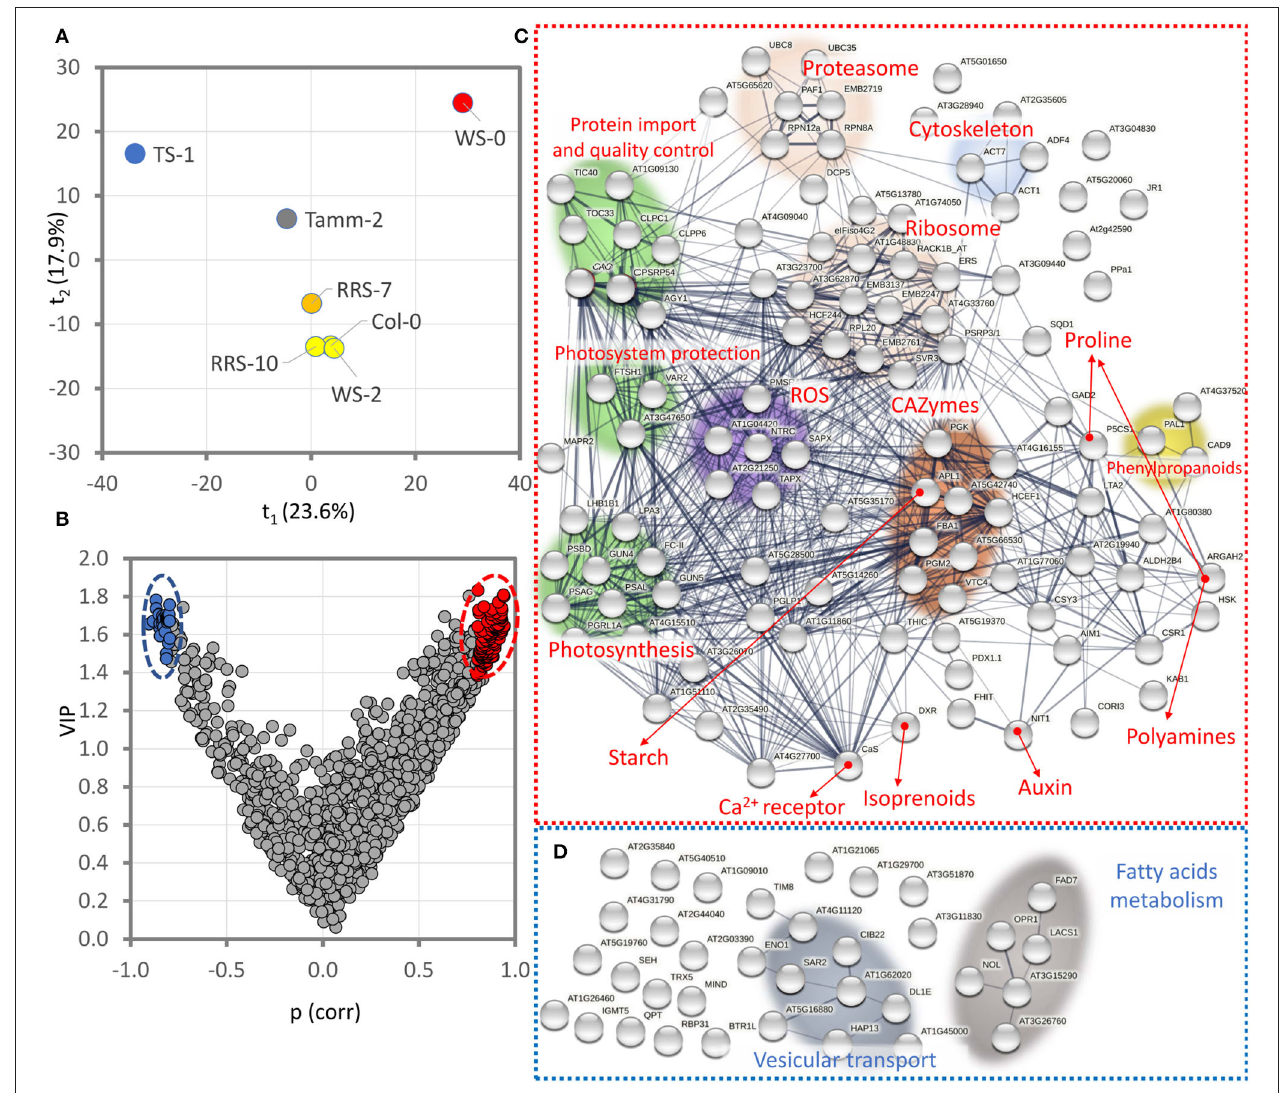
FIGURE 7 | Identification of putative protein markers of the contrasting response in R20 and B20 plants under cold stress. The ratios in protein abundance, ion leakage, Qy_lss, NPQ, and RFD were analyzed by partial least squares regression analysis (A) and VIP variables of importance in projection. (B) Projected ratios represent the means of at least four biological replicates. (C,D) Functional characterization of identified proteins showing positive correlations [red, p (corr) > 0.8, VIP > 1.4] and negative correlations [blue, p (corr) < -0.8, VIP > 1.4] with the OPLS distribution. Visualized by STRING (Szklarczyk et al., 2021). For details, see Supplementary Material S7